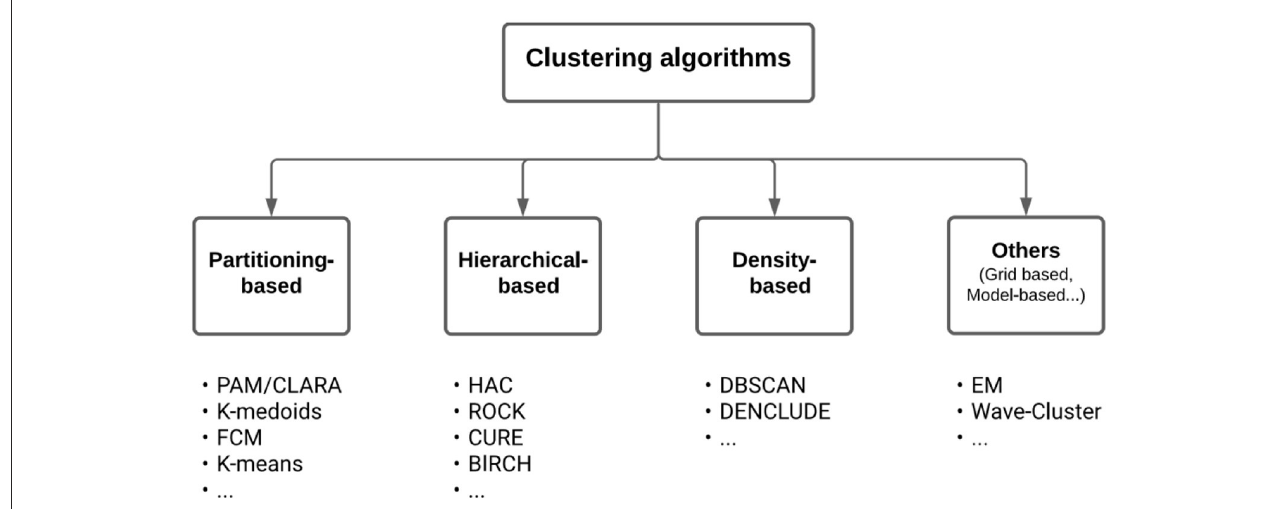
FIGURE2 A taxonomy of clustering algorithms. Below the boxes are listed well-known algorithms of the corresponding